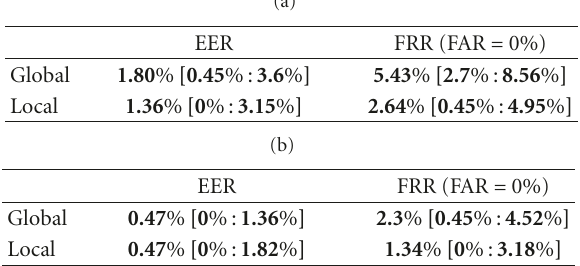
Table 3: EER and FRR (FAR = 0%) obtained with automatically segmented databases, for both global and local comparison meth- ods, on (a) CASIA and (b) ISEP databases. Note that the error rates were zero on the manually segmented databases.